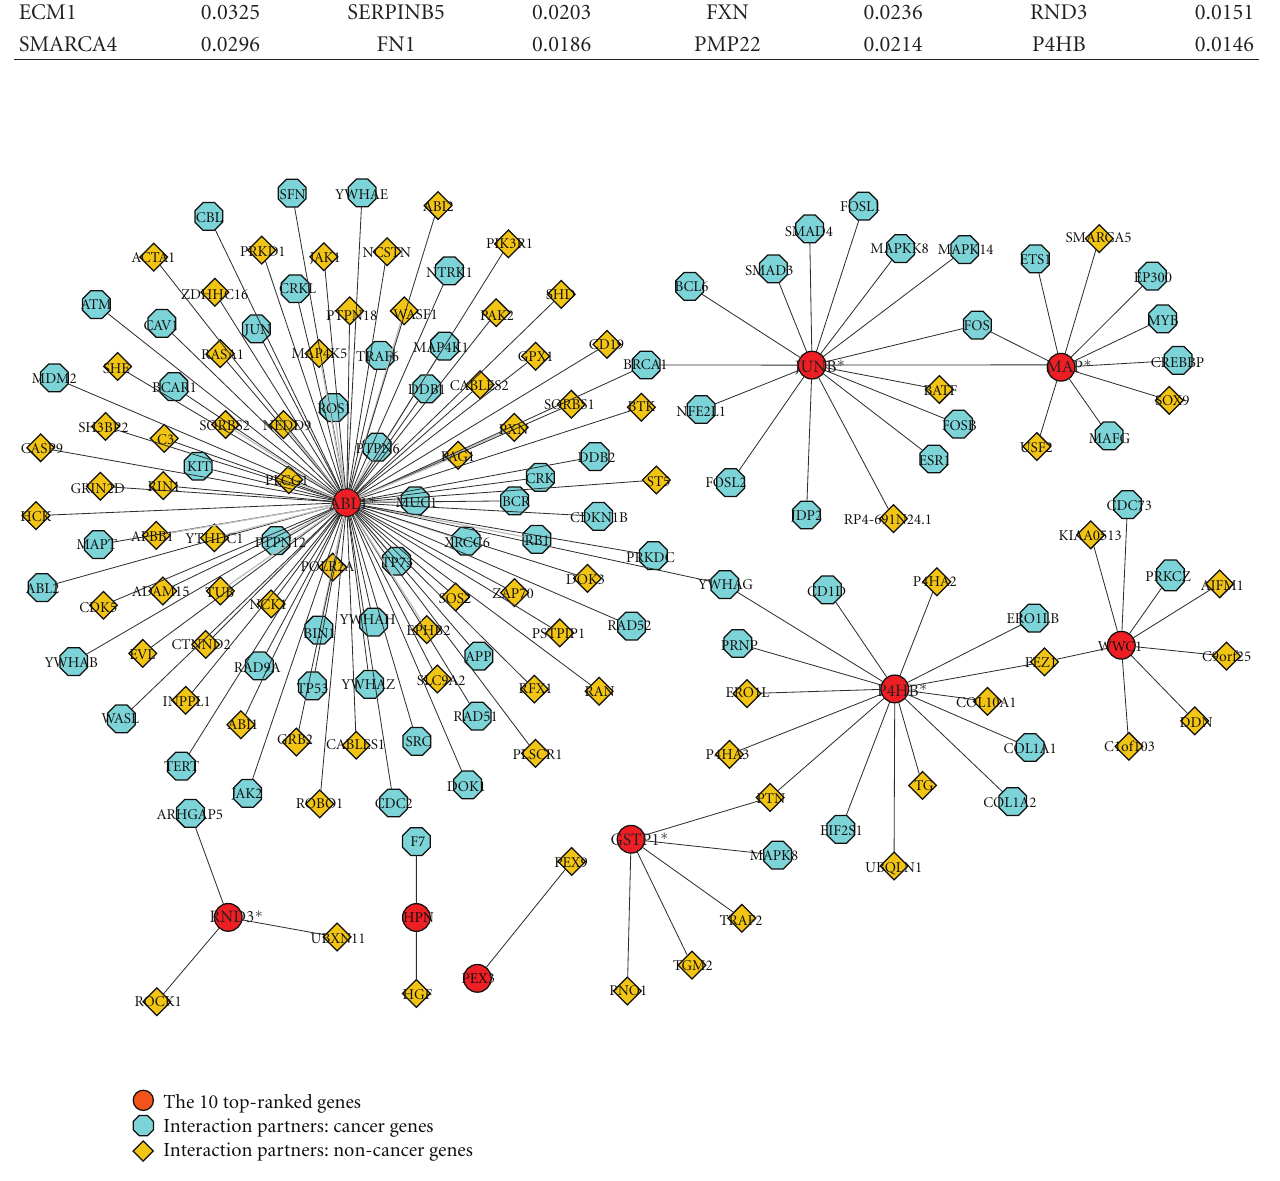
Figure 3: The protein-interaction network associated with the ten top-ranked genes for prostate